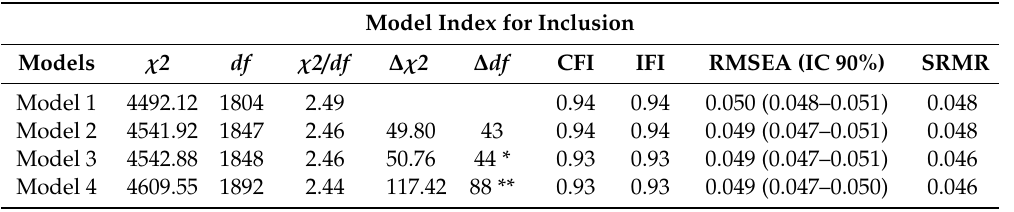
Table 1. Multi-group analysis of gender invariance.